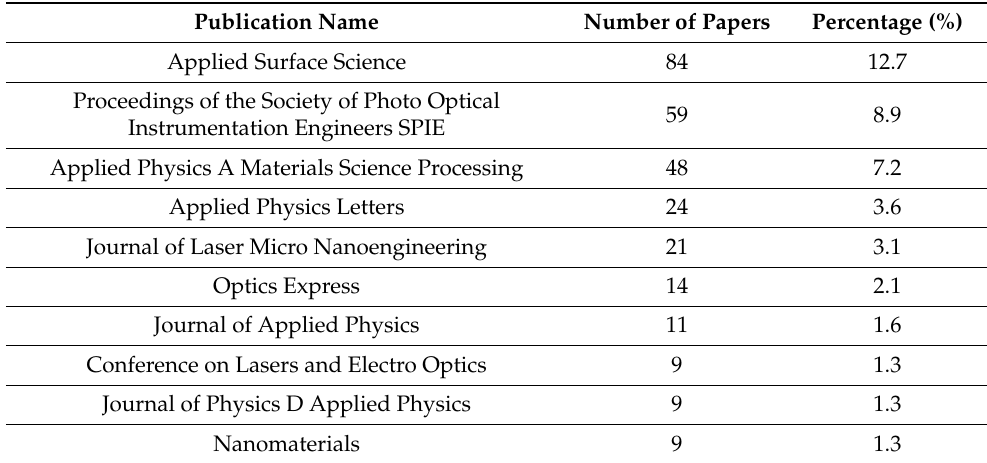
Table 1. Journal names and number of papers published on LIFT, according to the ISI Web of Science, by sorting the keyword “laser induced forward transfer” as of 11 November